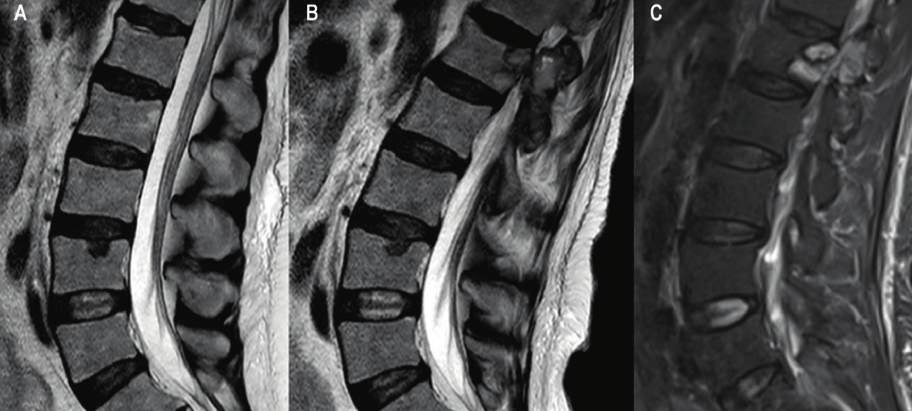
Figure 2: Sagittal spine MRI. (a) T2 weighted sequence from the same investigation as the latest thoracic image showing no lesions in L1. (b) T2 weighted sequence one year later showing tumor in the body and pedicle of L1. (c) T2 weighted Dixon fat suppressed sequence 9 months later showing no further progression of the